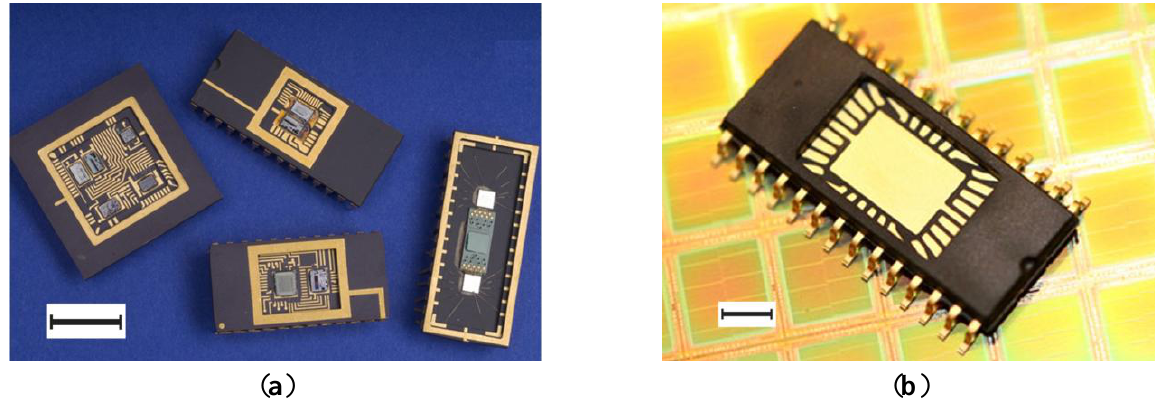
Figure 13. Example packaging technologies frequently adapted for MEMS